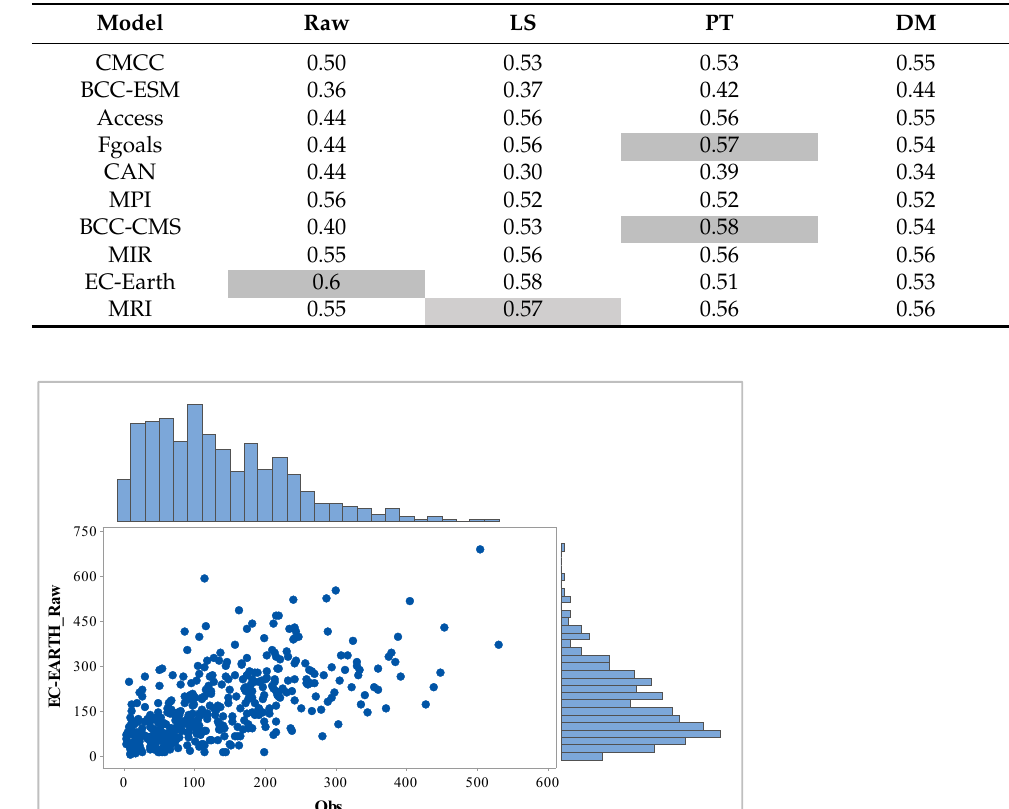
Table 5. Correlations between precipitation reference data and GCMs data with different bias correction methods.